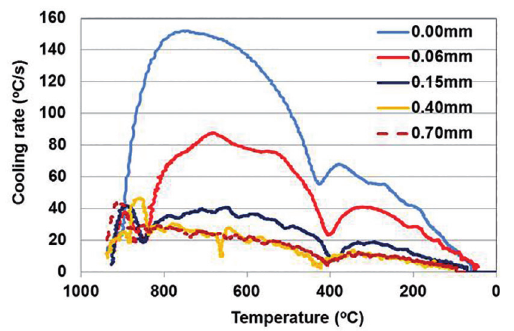
Figure 9: Cooling rate curves for different